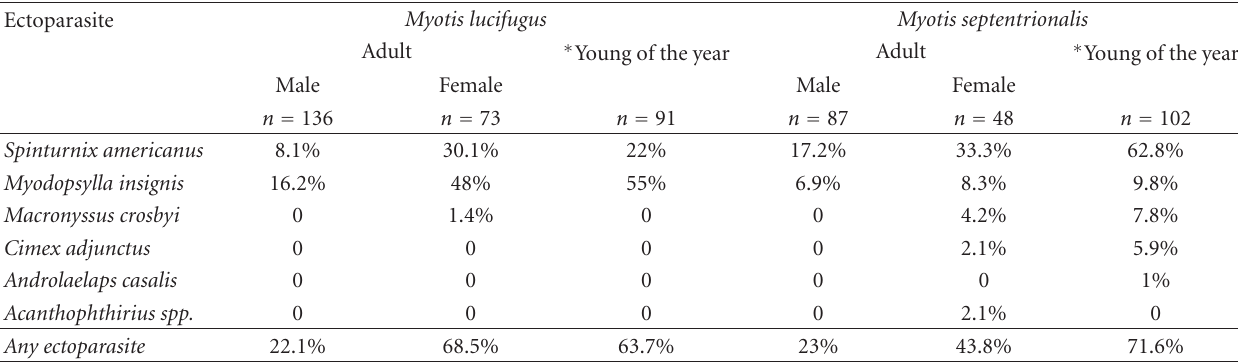
Table 1: Prevalence of ectoparasites among the di ff erent host groups at all sample sites in Nova Scotia and New Brunswick during swarming, Aug–Oct 2010.